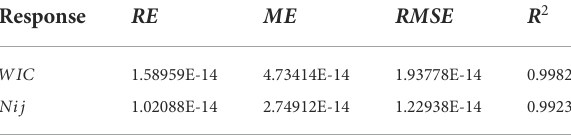
TABLE 7 Error estimation of the response surface